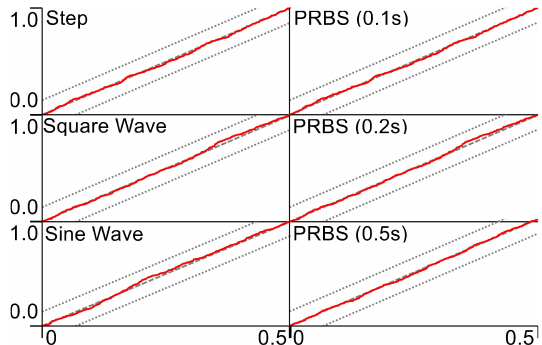
Figure 9: Cumulative Periodograms for all six data- sets show that the residuals are close to Gaus- sian distributed, well within the 95% confid- ence